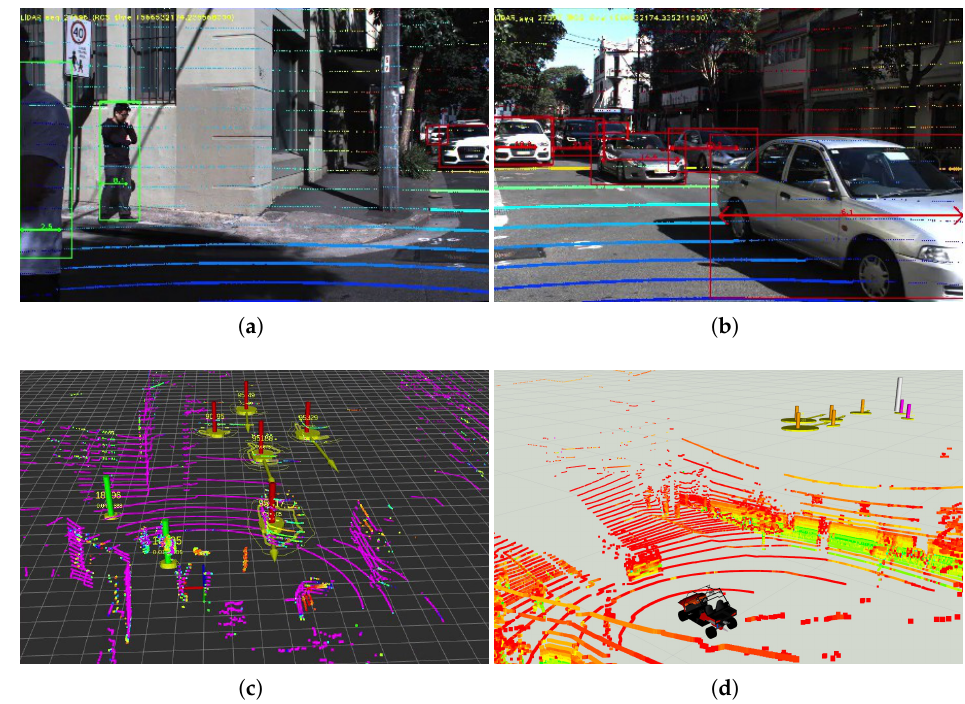
Figure 14. The road user detection and tracking in the IRSU and CV in the Abercrombie St experiment. ( a , b ) show the image frames from Cam #1 and #2, respectively, overlaid with pedestrians and vehicles bounding boxes and projected lidar point cloud in the IRSU. The detection results from the dual cameras and the lidar were then fused within the IRSU for tracking in 3D space, as visualised in ( c ). The detection results were encoded into CPMs and transmitted to the CV, where they were decoded, transformed, and used in the CV’s local frame. In the particular traffic scene shown in ( c ), the generated CPM contains one Sensor Information Container and seven Perceived Object Containers , two for pedestrians and five for vehicles. ( d ) illustrates the tracking results of the same group of road users within the CV at the same time. Due to the change of visualisation colours in IRSU and CV, the vehicles in orange pillars in ( d ) correspond to red ones in ( c ), while the pedestrians in magenta pillars correspond to green ones in ( c